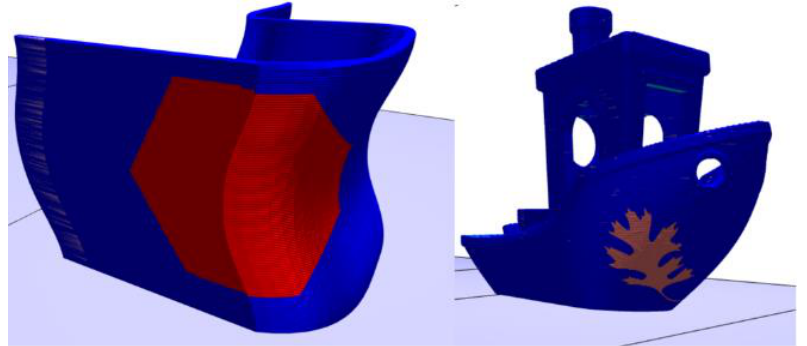
Figure 8. Examples of embossing on non-flat surfaces. Left : Hexagon on chair bottom. Right : Oak leaf on tugboat.